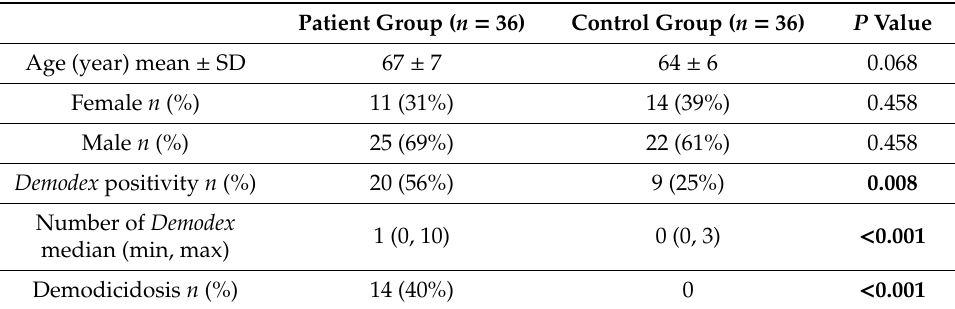
Table 2. Comparison of the patient and control